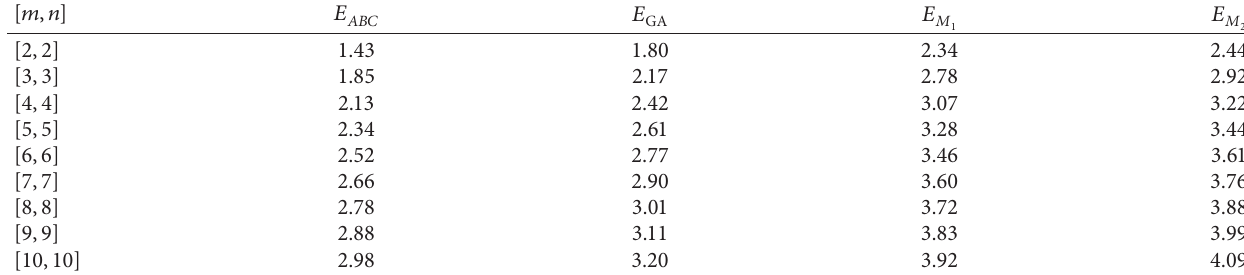
E , E M , and E M ABC , GA 1